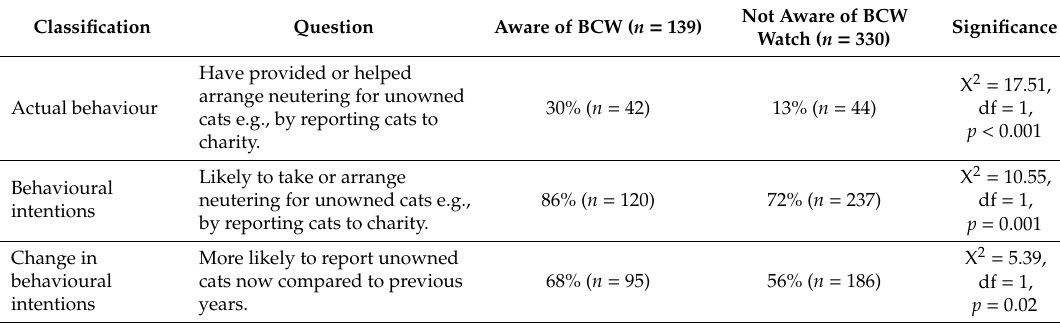
Table 2. Results from close-ended questions on behaviours (actual, intentions and change in intentions) around reporting of unowned